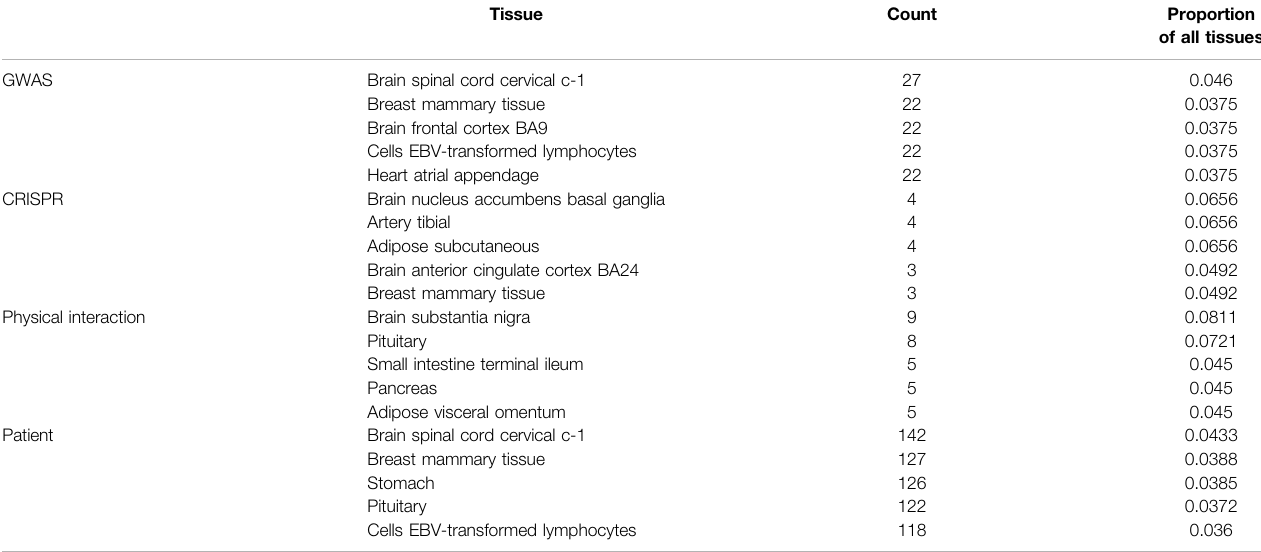
TABLE 1 | Top fi ve tissue context in embedding of known COVID-19 genes discovered by different study types, expressed as counts and proportion of all tissues.